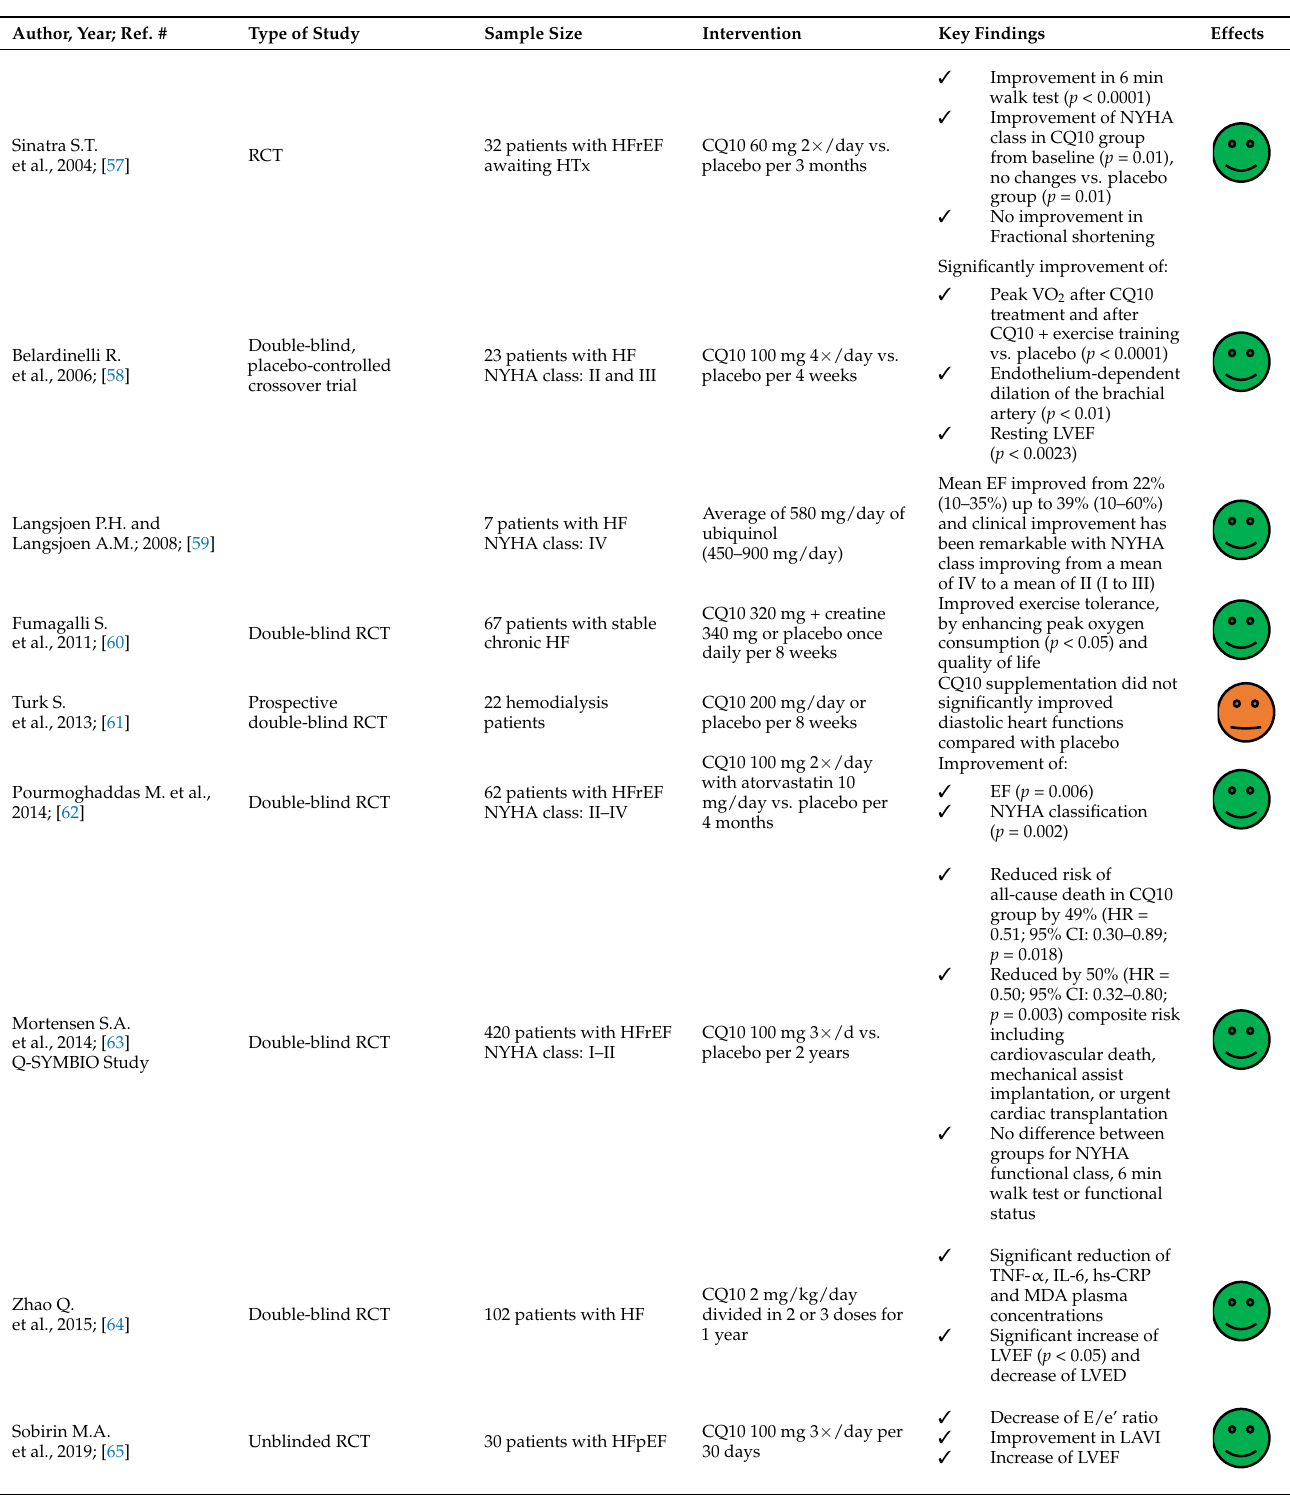
Table 2. Studies evaluating the effectiveness of CoQ10 supplementation in the treatment of HF. The only studies with multicenter, prospective, randomized, double blinded, placebo controlled, soft and hard endpoints protocols are bolded; the ones with all-cause mortality reduction positive re- sults are in red among those. Superiority (smiling, green faces) on the contrary to inferiority ones (non-smiling, orange faces) were put by the authors judging objectively the findings of coenzyme Q10 action in the particular study. HF — heart failure; NYHA — New York Heart Association;